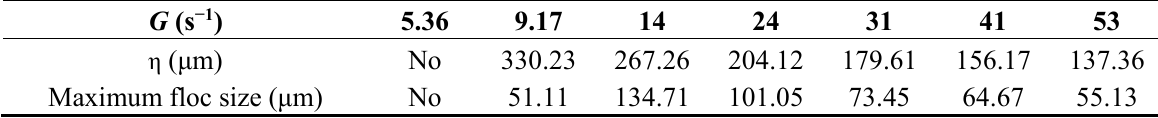
Table 3. Comparison of the Kolmogorov micro-scale and maximum floc size with respect to different shear rate, observed during the flocculation process at φ = 7.87 × 10 − 5 without electrolyte added into the